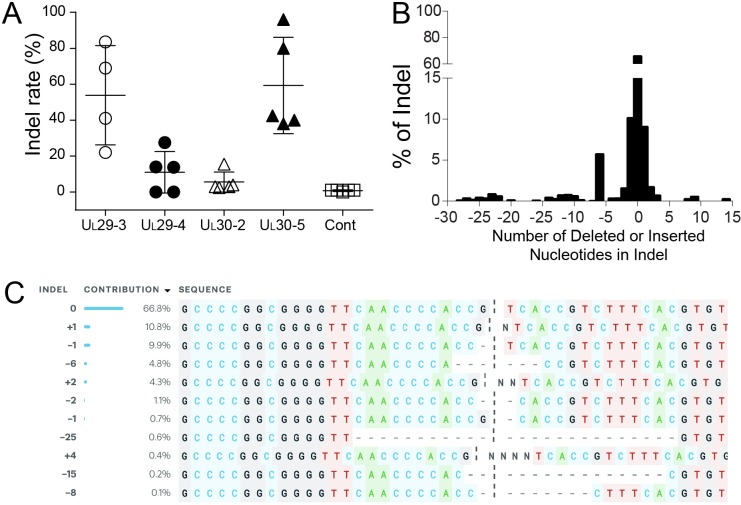
Indel mutations in the HSV-1 genome during the quiescent infection.(A) Indel mutation frequencies of quiescent d109 genomes are shown at the indicated sgRNA target sites. (B) Histogram representing the frequency (count) of indel lengths induced by SaCas9/UL30-5 in quiescent d109 genomes. (<0) deletions (>0) insertions. (C) Examples of sequences that show mutations induced by SaCas9/UL30-5 in quiescent d109 genomes.